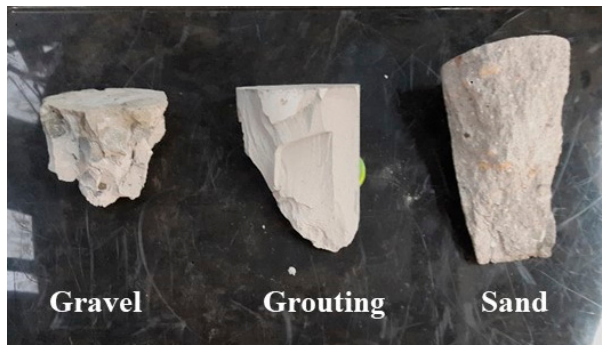
Figure 2. Test samples for surface roughness analysis.